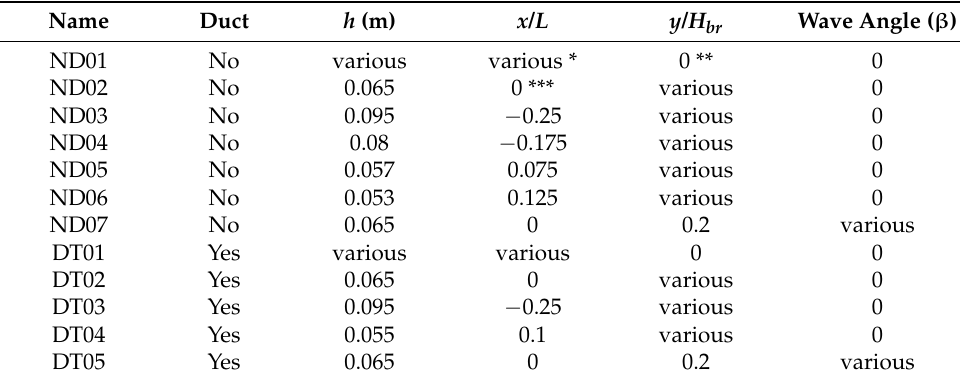
Table 1. Data test setting used in the current study.